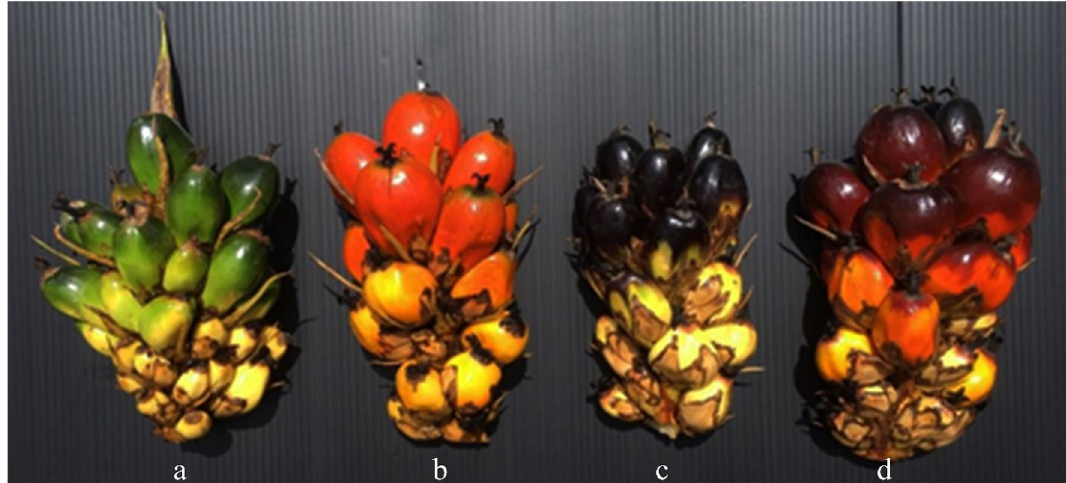
Figure 7. Exocarp morphotypes of oil palm fruit. ( a ) Virescent type; unripe. ( b ) Virescent type; ripe. ( c ) Nigrescent type; unripe. ( d ) Nigrescent type; ripe. (unripe: four weeks after fertilization, ripe: 15 weeks after